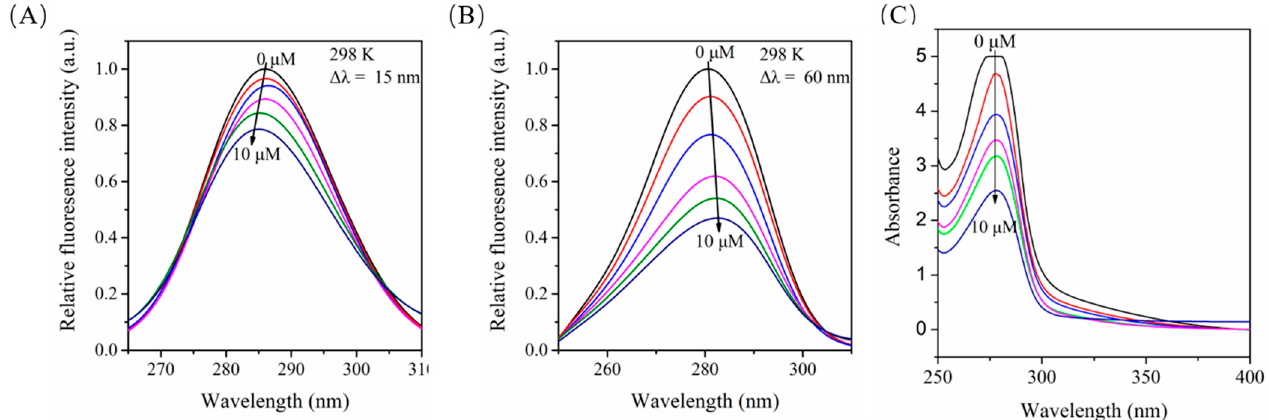
Figure 5. Effects of Myr on the conformation of BSA. ( A , B ) represent the synchronous fluorescence spectra of the interaction between Myr and BSA at Δλ = 15 nm and Δλ = 60 nm, respectively. ( C ) UV- vis absorption spectra of BSA in absence and presence of Myr (0, 2, 4, 6, 8, 10 μ M).